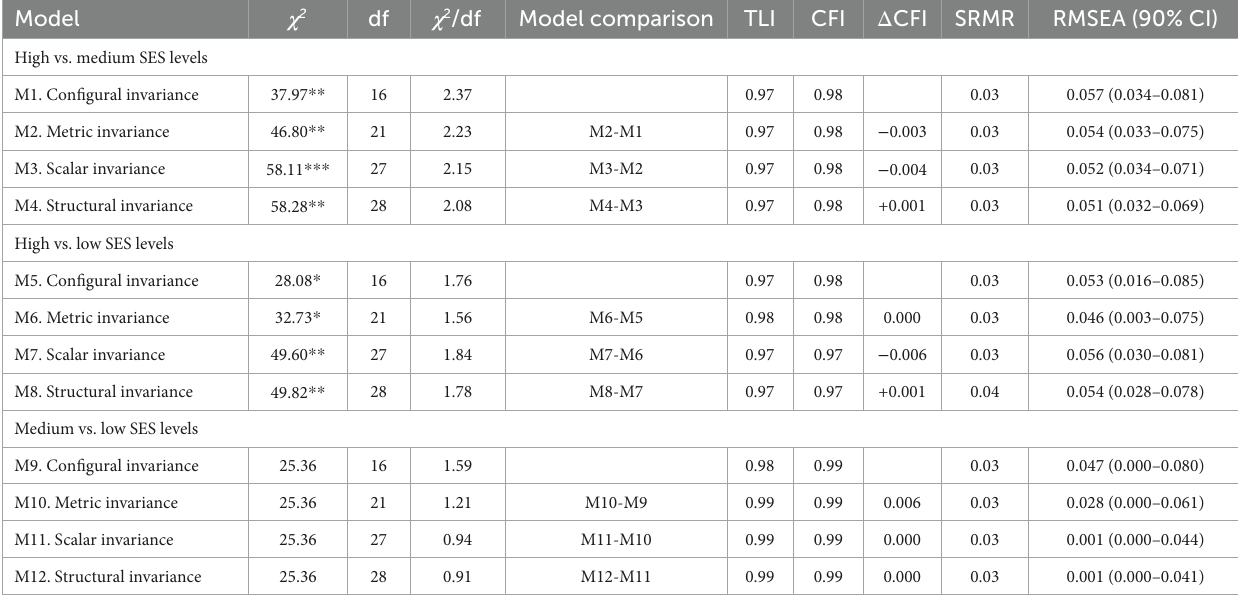
TABLE 6 Testing for factorial invariance of ARS_SCV across SES levels ( n = 569). Model χ 2 χ 2 /df Model